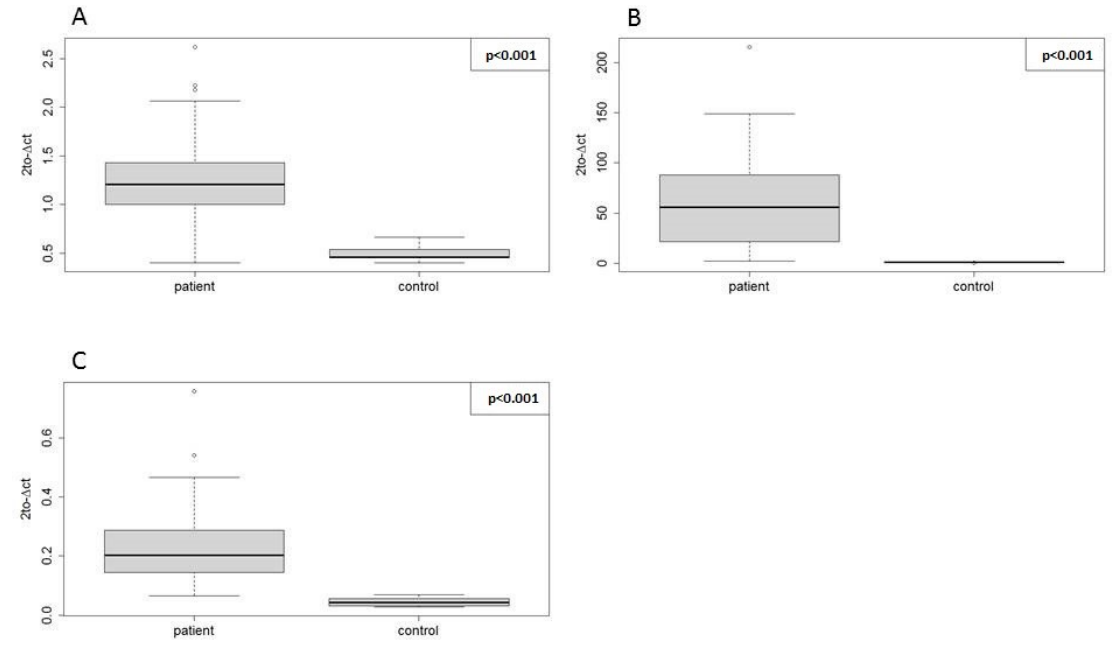
Figure 5. Normalized relative expression levels of miRNAs overexpressed in T-ALL vs. controls. ( A ) hsa-miR-20b-5p, ( B ) hsa-miR-181a-5p, and ( C ) hsa-miR-128-3p in patients (34 T-ALL samples) and in controls (5 samples of mature T-lymphocytes obtained from the bone marrow of healthy donors). Dots represent relative gene expression in individual samples. Upper and lower edges of boxes correspond to first (Q1) and third (Q3) quartiles, respectively. Lines inside boxes indicate median expression values. Whiskers extend to the smallest and largest observations within the 1.5-times interquartile range (IQR) from the box. Table 5. Validation of expression levels for selected miRNAs with oncogenic role in T-ALL. miRNA-Seq miRNA Name